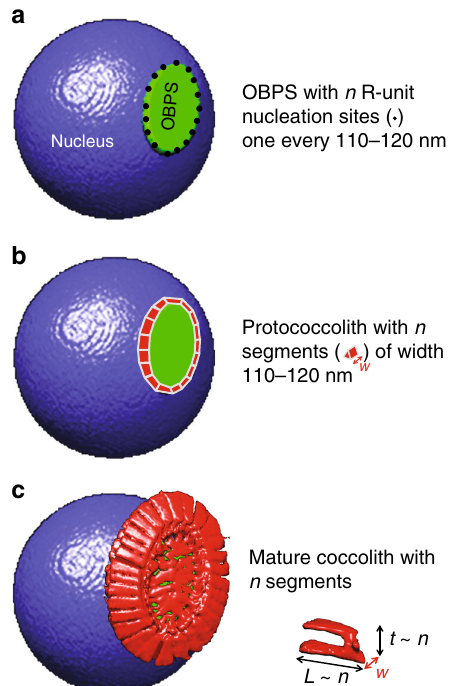
Fig. 5 Scheme summarizing the link between OBPS size and coccolith mass. a Formation of the OBPS (in green) on the cell nucleus (in blue). The OBPS is decorated with n R-unit nucleation sites, one every 110 – 120 nm in average. b Nucleation of the protococcolith (PC) (in red) around the OBPS. The PC contains n segments with an average width w = 110 – 120 nm. c In- plane (forming the rim of length L ) and out-of-plane (forming the tube of height t ) growths of the coccolith. With L and t almost proportional to the segment number n and with w a constant equal to around 110 – 120 nm, the average mass of each segment is almost proportional to n 2 . The symbol ~ refers to “ almost proportional to ” . This leads to a coccolith mass